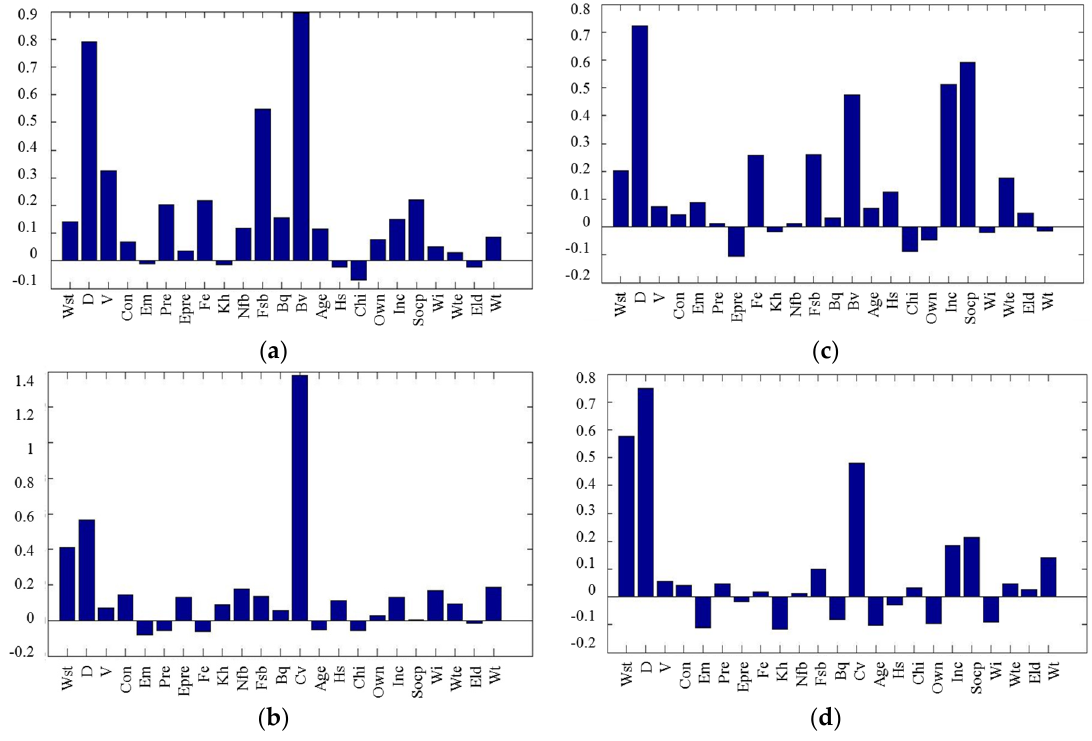
Figure 3. Out-of-bag feature importance for bagging decision tree building loss ratio ( a ); content loss ratio ( b ); absolute loss for building ( c ); absolute loss for content ( d ).